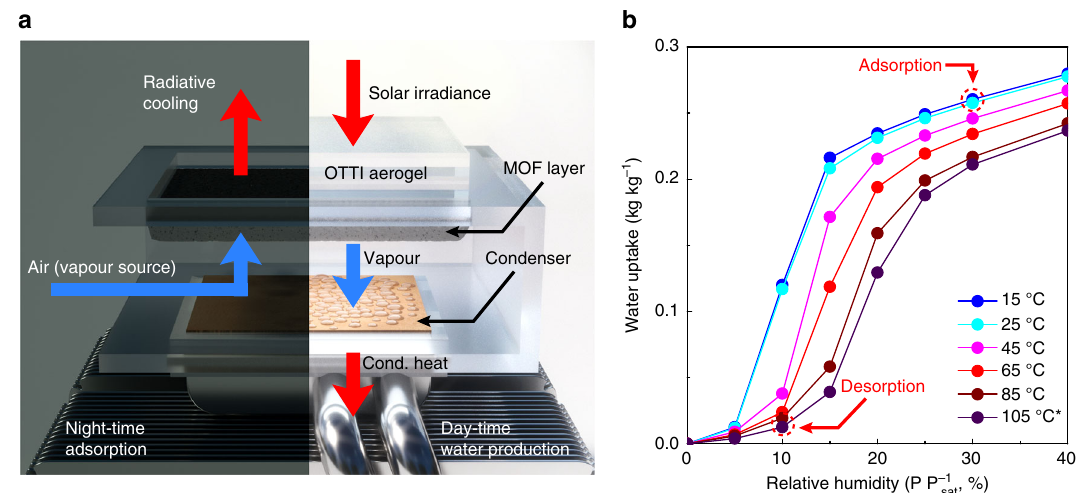
Fig. 1 Working principle of the MOF-801-based water harvesting device and adsorption isotherms. a Illustrative schematic of the water harvesting device undergoing adsorption (night-time, left half) and solar-assisted water production (day-time, right half) processes. During adsorption, air is circulated around the MOF layer and water from air is adsorbed. Passive radiative cooling lowers the MOF layer temperature below the ambient by dissipating thermal radiation to the clear cold sky to increase the effective RH for adsorption. During water production, the OTTI aerogel is stacked on top of the MOF layer to suppress convective heat loss from the solar absorber. The desorbed vapour is condensed on a condenser and the heat of condensation is rejected to the ambient by a heat pipe heat sink. b Water adsorption isotherms of MOF-801 in kg kg − 1 (kg of water per kg of MOF-801) as a function of relative humidity (P P sat − 1 , vapour pressure over saturation pressure) at temperatures of 15, 25, 45, 65 and 85 °C measured using a sorption analyser (Q5000